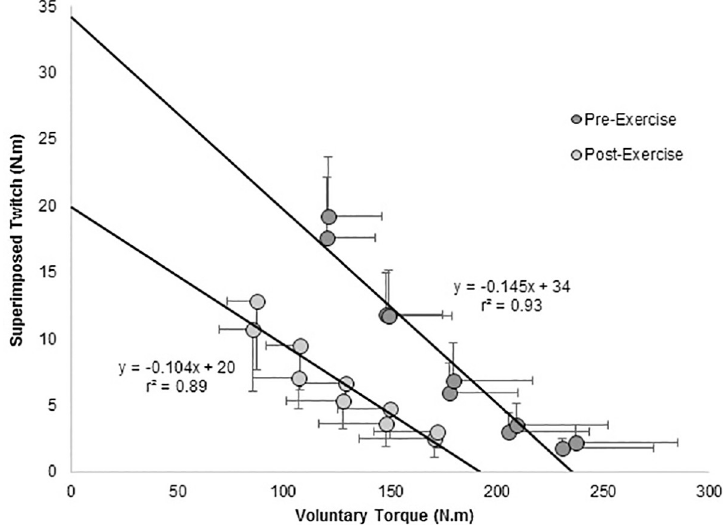
Fig 2. Relationship between voluntary contraction (VC) and superimposed twitch force (SIT) pre- and post-